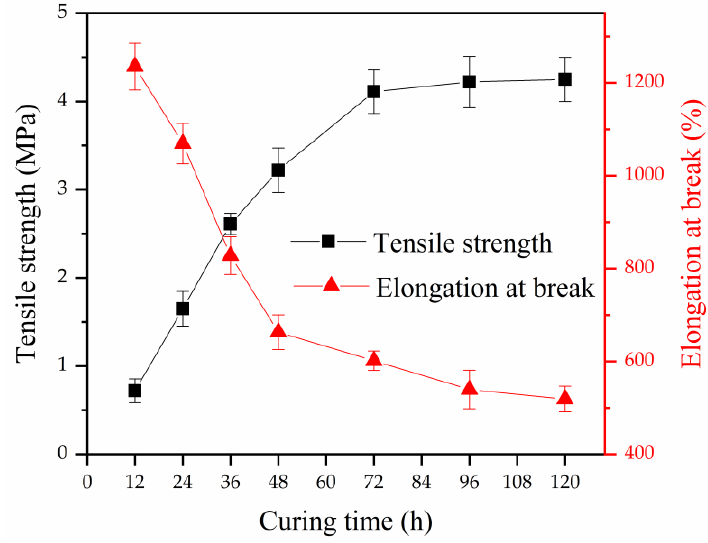
ff erent curing